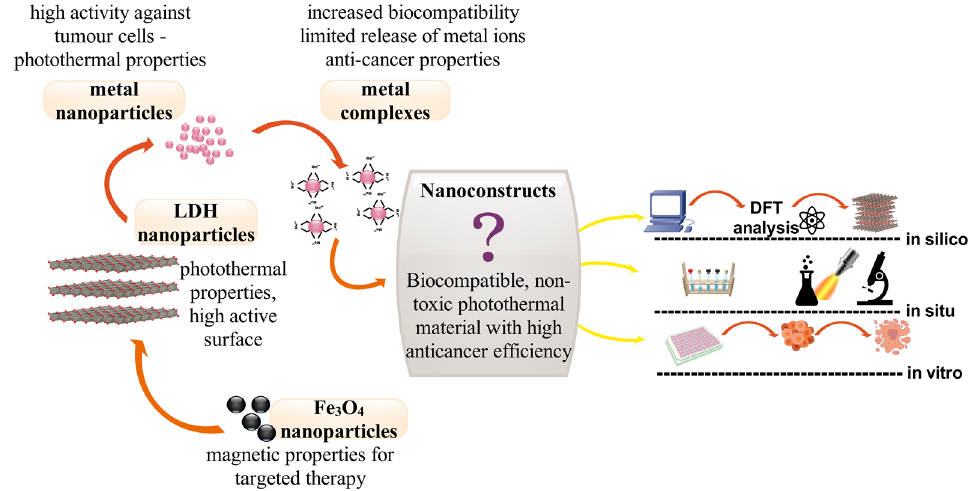
Figure 1. The idea of the nanocostructure and the research cycle envisaged to con fi rm its